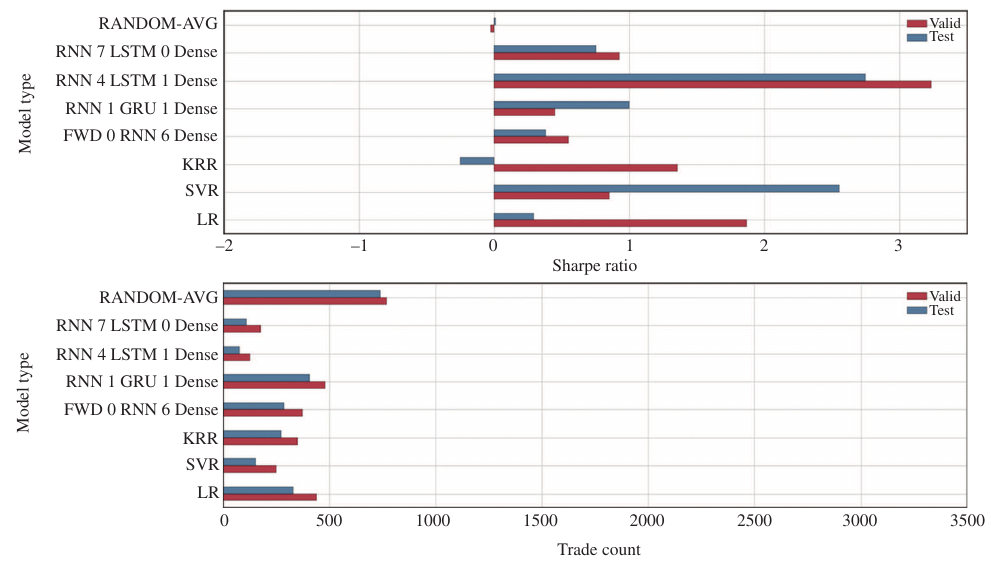
Figure 5: Performance of Regression Models on 60-Min Exit Strategy.